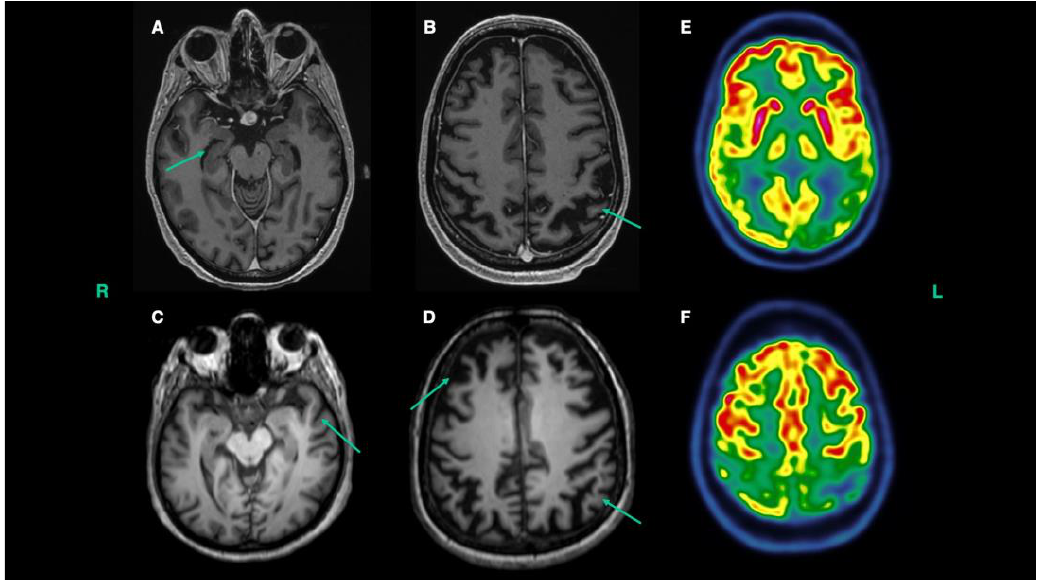
Figure 1. Structural and functional imaging of the proband and her mother. Brain axial T1 MRI scan of the proband showed bilateral hippocampal atrophy ( A ) and bilateral, left-predominant frontoparietal ( B ) atrophy. Brain axial T1 MRI scan of the proband’s mother showed bilateral anterior temporal ( C ) and frontoparietal atrophy ( D ). Brain 18-FDG-PET scan of the proband showed bilateral, left predominant temporoparietal hypometabolism ( E , F ).